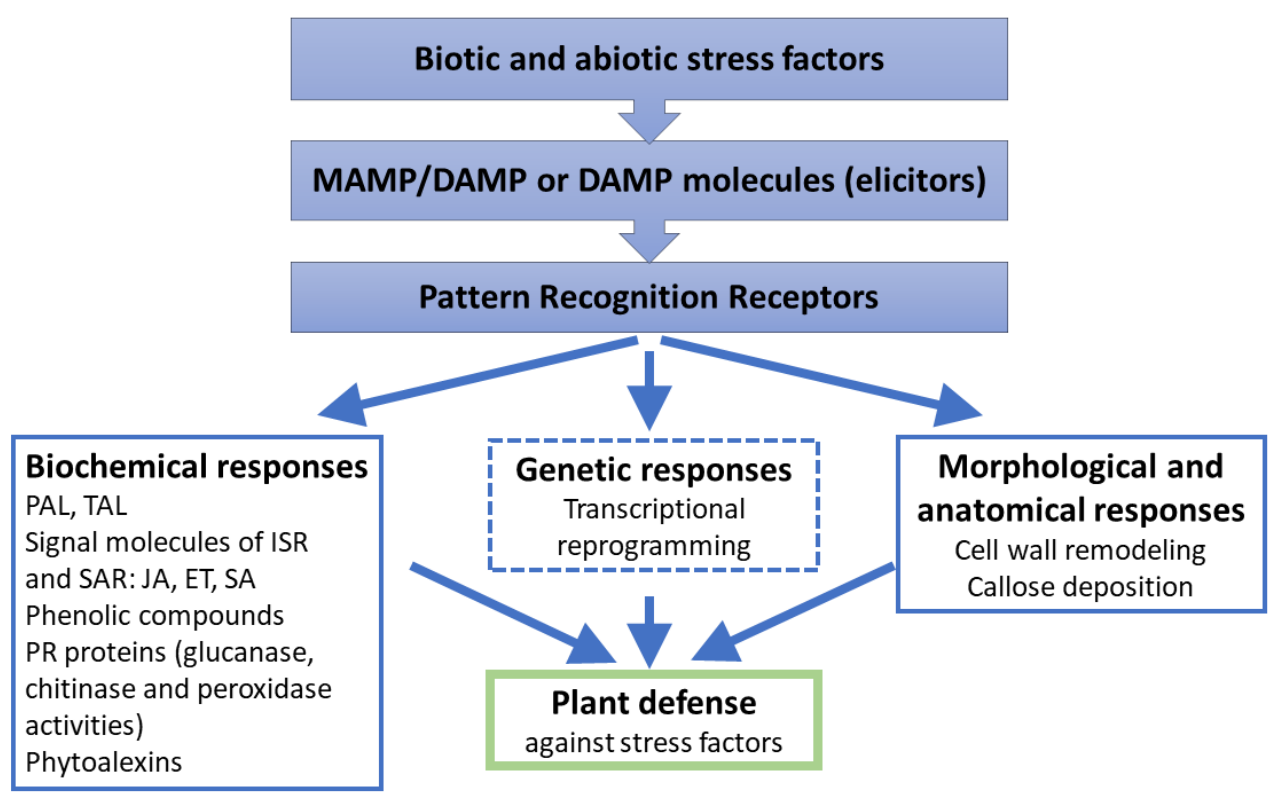
Figure 3. Immune response of plants against stress factors (modified on the basis of [71,72]); PAL—phenylalanine ammonia-lyase; TAL—tyrosine ammonia-lyase; ISR—induced systemic resistance, SAR—systemic acquired resistance; JA—jasmonic acid; ET—ethylene; SA—salicylic acid; PR proteins—pathogenesis related proteins.